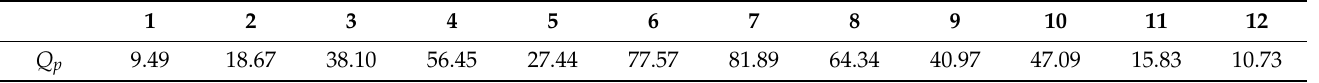
Table 9. Monthly heat production from a flat collector (kWh t /m 2